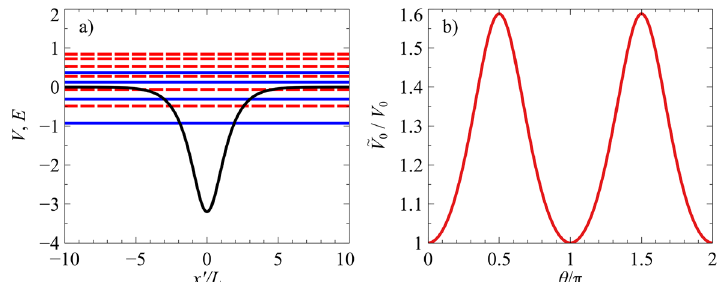
V 0 / cosh ( x ′ / L ) , for the case Figure 2. ( a ) The black curve shows the hyperbolic secant potential V ( x ′ ) = − 3.2 . The dashed and solid horizontal lines are the bound-state energy levels for the s 1 and s 1 of V 0 = = = − chirality, respectively (which corresponds to the K and K ′ valley in the effective graphene sheet), for the case 0 . The tilted Dirac material is defined by 1 , when the waveguide is orientated at angle θ k y L of (cid:31) ′ = = = 0.86 v F , v 0.32 v F . ( b ) The relative strength of the effective potential’s 0.69 v F and v parameters v x t = y = =